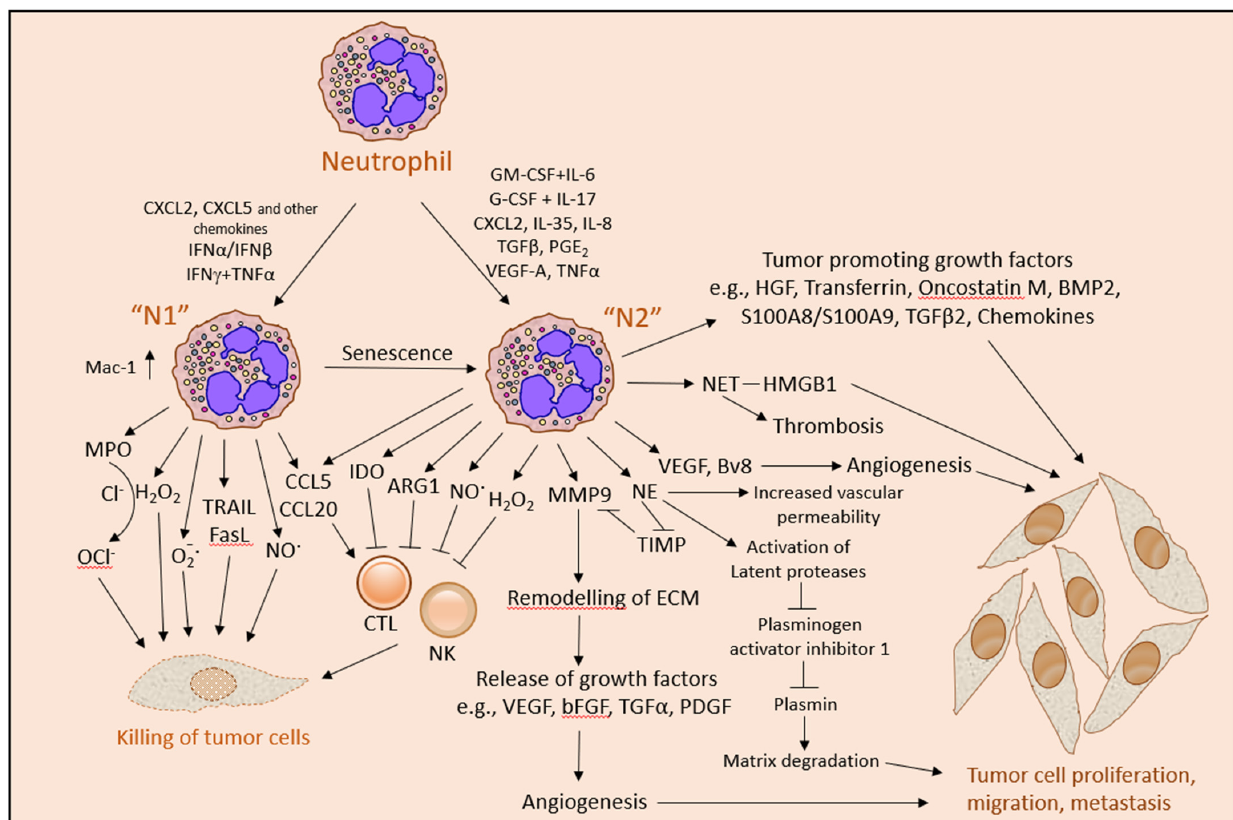
Figure 3. The intricate anti- and pro-tumor functions of neutrophils. The activities of neutrophils can be modulated by a wide range of factors produced by tumor cells, stromal cells, neutrophils and other immune cells. Chemokines and certain cytokine combinations in the presence of interferons can activate the neutrophils to an anti-tumor “N1” phenotype. These neutrophils are important for tumor cell rejection either by a direct tumor cell killing caused by a combination of the cytotoxic molecules H 2 O 2 , O 2 − · , OCl − , NO · , TRAIL and FasL, or indirectly by recruiting cytotoxic T lymphocytes (CTL) and NK cells that eliminate the tumor cells. Other cytokine/chemokine combinations can lead to an alternative activation of the neutrophils to acquire a pro-tumor “N2” phenotype that promotes tumor cell proliferation and migration by secreting tumor promoting growth factors and by remodeling the extracellular matrix (ECM). In addition, the “N2” neutrophils promote angiogenesis, which is important for tumor cell expansion, and repress CTL and NK anti-tumor functions. The “N2” population is heterogeneous, composed of immature LDNs, G-MDSCs and senescent neutrophils.